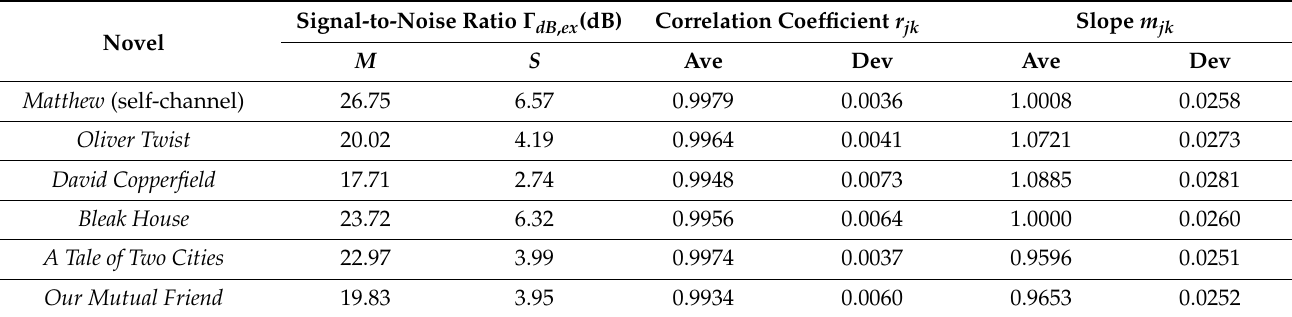
Table 10. Average value M (dB) and standard deviation S (dB) of Γ dB , ex (dB) in self- and cross- channels, correlation coefficient r jk , and slope m jk of the regression line between the number of sentences n S of Matthew (channel output, self-channel) versus the number of sentences n S in Dickens’ novels (channel input, cross-channels), for equal number of words, in the sentences channel.